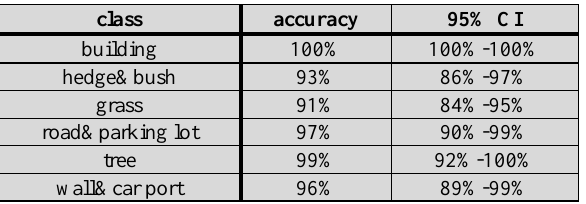
Table 8. User’s accuracy with CIs derived from 6∙91=546 randomly selected cells of the training areas (SVM- classification)